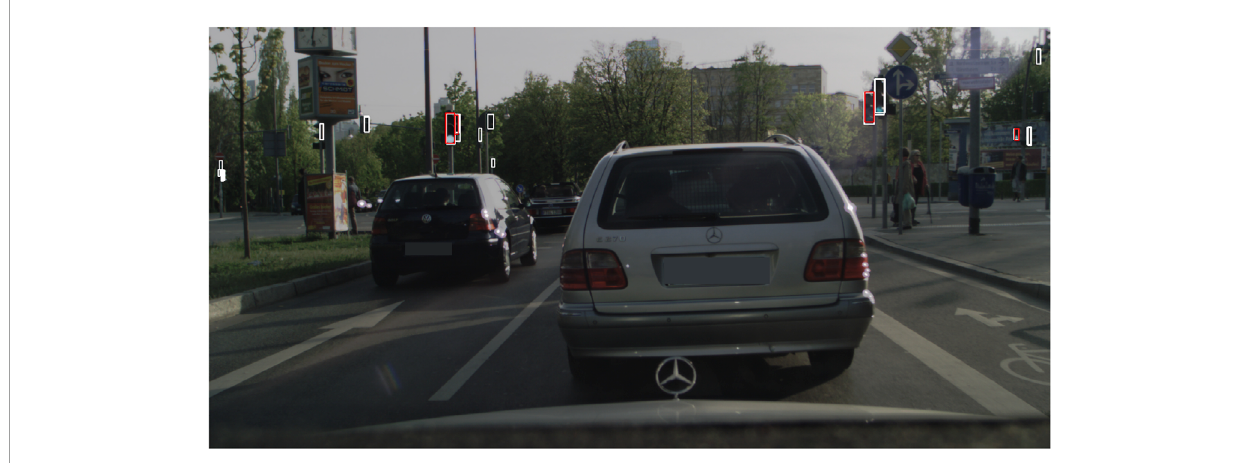
FIGURE 3 Sample image from the test set of DTLD. In white the detection of Faster R-CNN-R50-FPN, and red the labels annotated in the DTLD. It is possible to notice how the model can detect lights which are correct, but not annotated in the dataset’s ground truth.